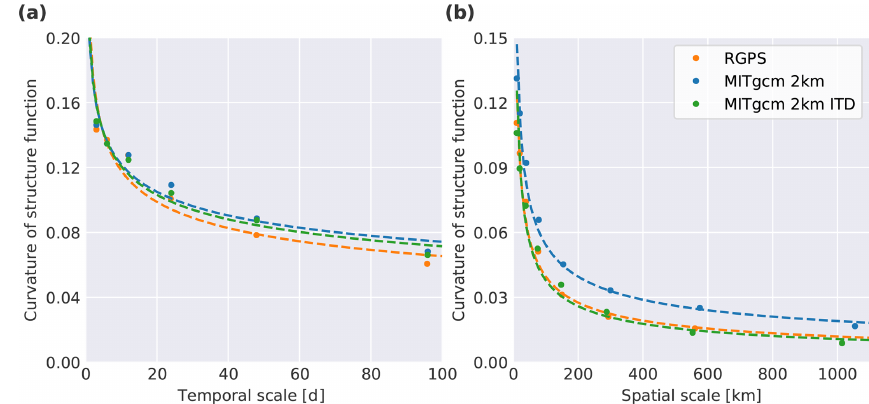
Figure 3. Spatiotemporal coupling of multi-fractal scaling: (a) the curvature of the structure function of the spatial scaling exponent as a function of temporal scale for RGPS data and both model simulations. (b) The curvature of the structure function of the temporal scaling exponent as a function of spatial scale. The dashed lines provide power law fits to the decay of the